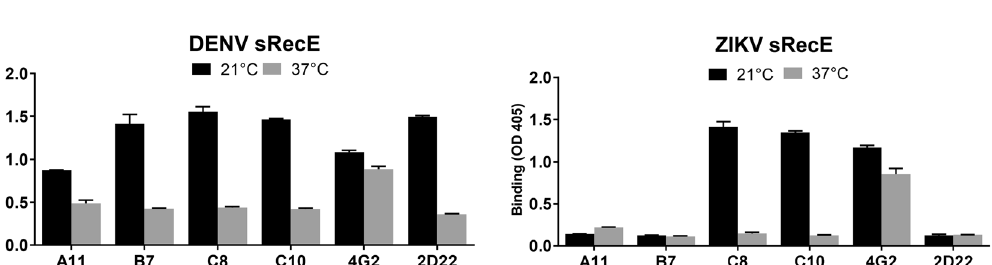
Figure 4. Antibody mediated dimer assembly. Indicated amounts of DENV and ZIKV sRecE were incubated with 500 ng of ( A ) 2D22, 4G2, ( B ) A11, B7, C8 and C10 mAbs in solution. Protein/mAb complexes were loaded on Ni 2 + -coated plates and captured antibodies were detected. Statistical analysis was performed using the student T-test.